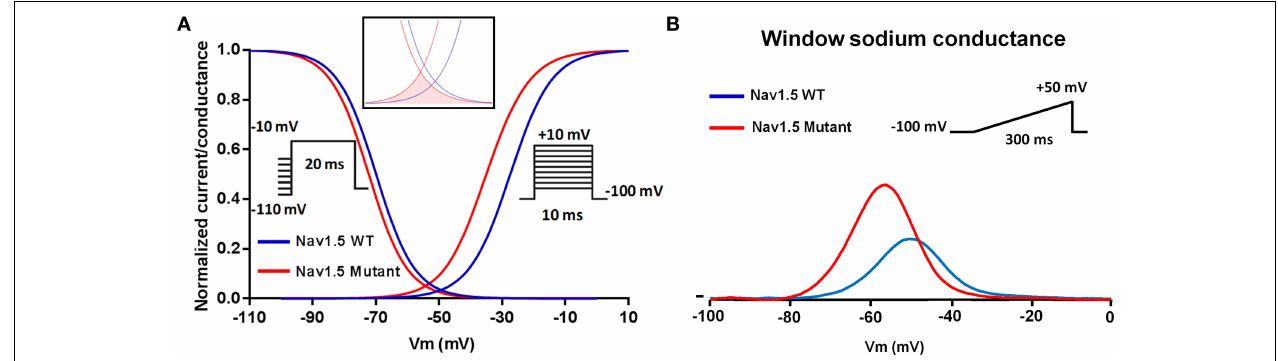
FIGURE 2 | Schematic representation of the shared mechanism of Na v 1.5 mutations associated with cardiac hyper-excitability. Negative shift of the voltage dependence of activation (A) leading to a negative shift of the sodium window conductance (B) .